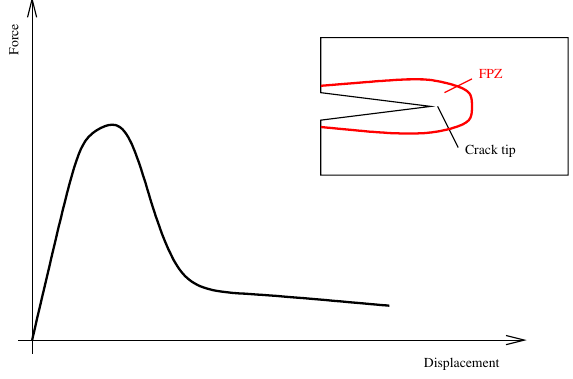
Figure 1. Typical F–d curve of a quasi-brittle ma- terial subjected to flexural loading (left), schematic propagation of FPZ (right)